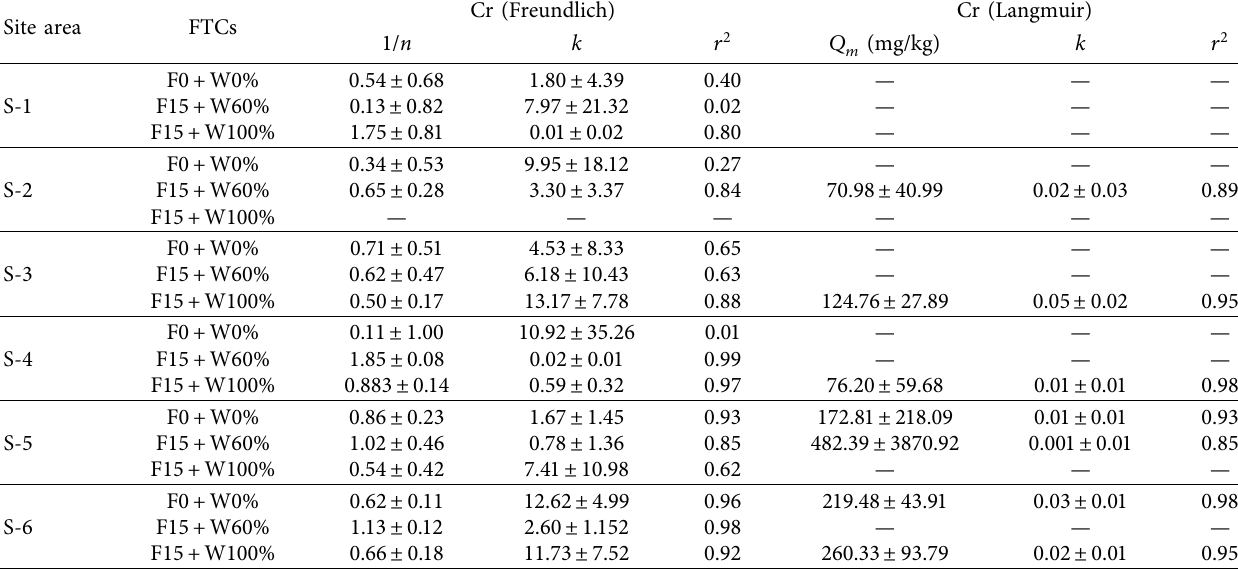
Table 2: Freundlich and Langmuir parameters of Cr in soils under different freeze-thaw conditions. Cr Site area FTCs